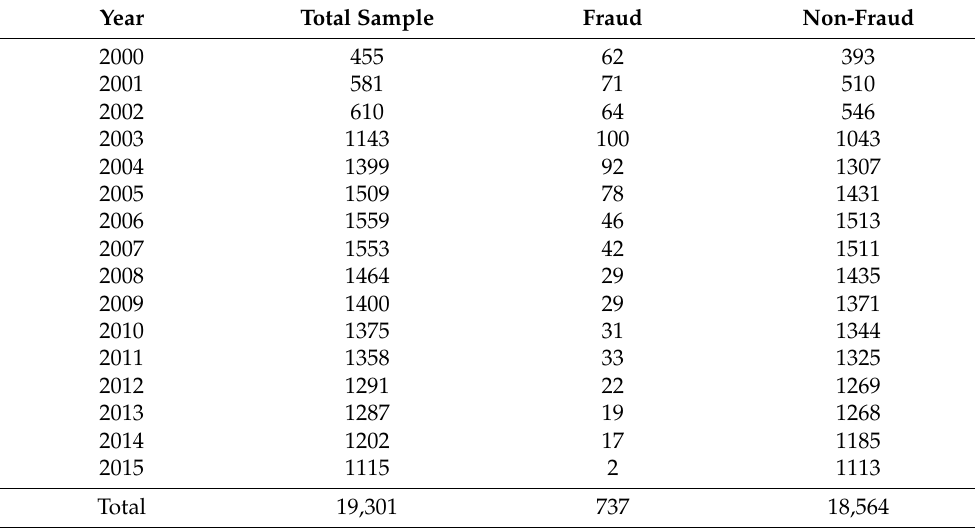
Table 1. Firms distribution by years for fraud and non-fraud